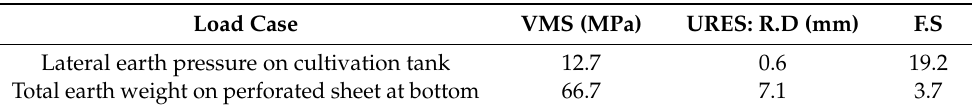
Table 4. Results of the analysis for the sides of the cultivation tank, its main structure and the base structure of the lysimeter.